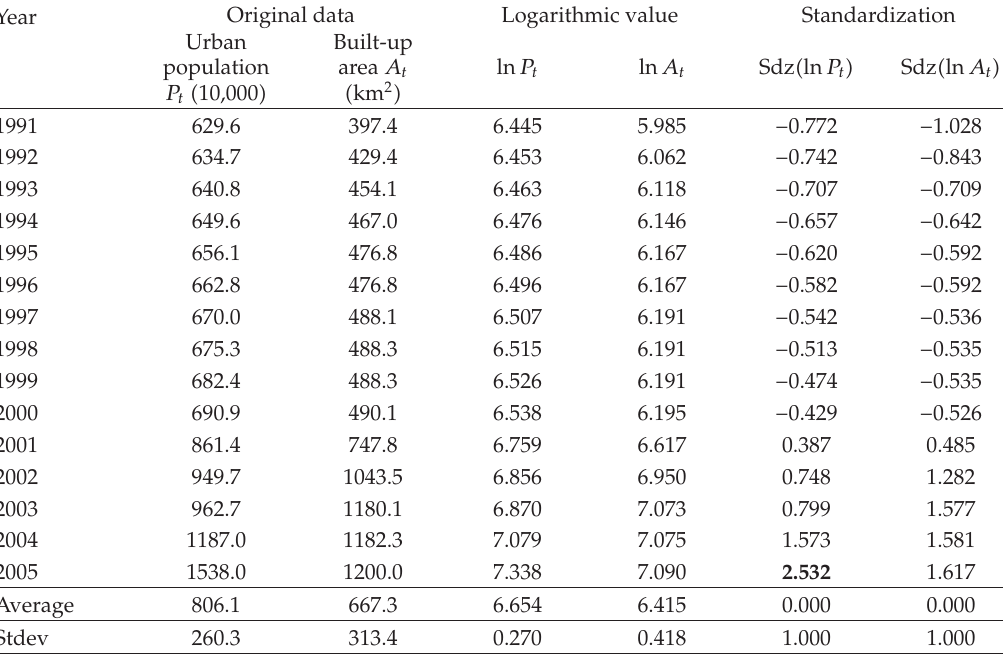
Table 2: The urban area and population of Beijing from 1991 to 2005.